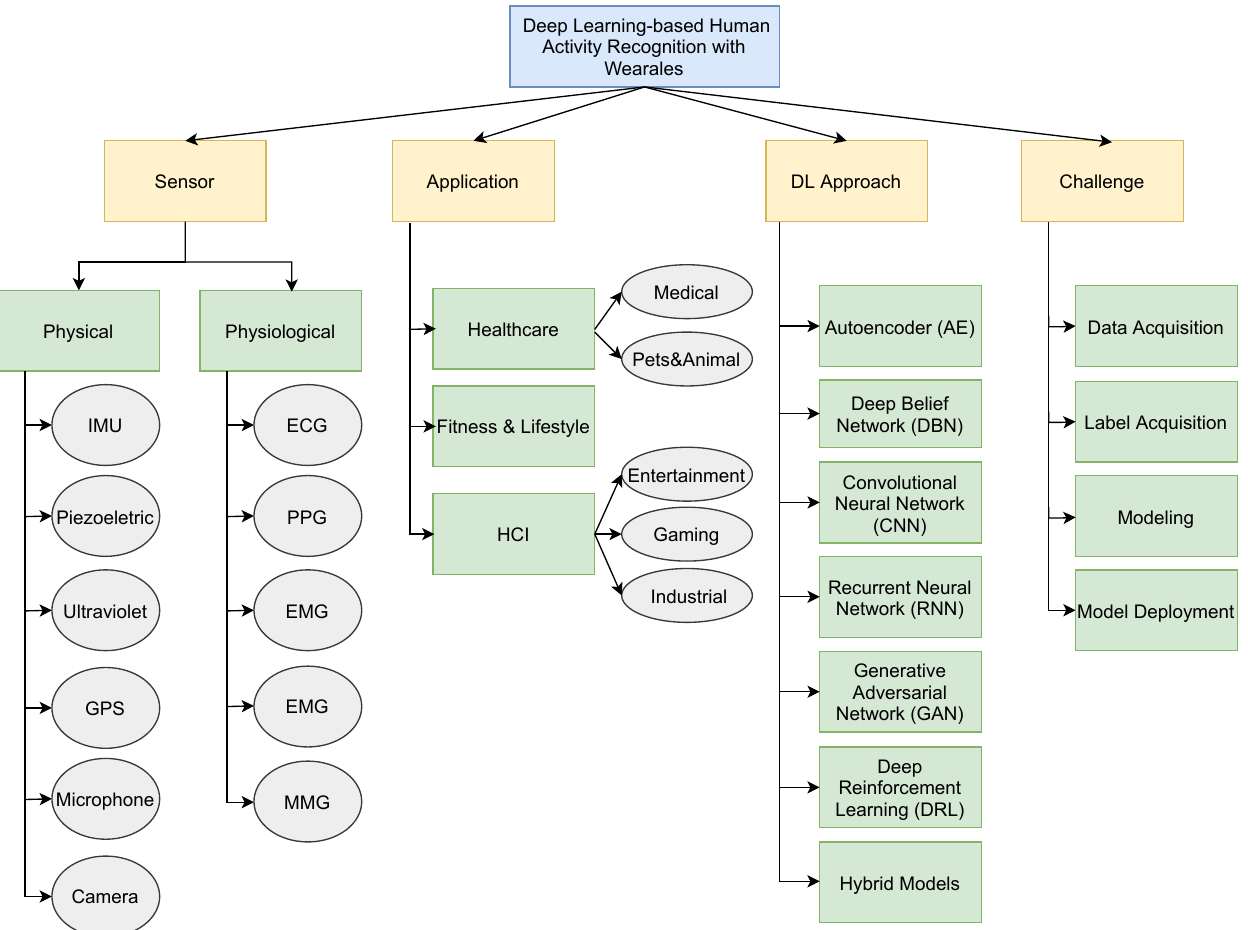
Figure 3. Taxonomy of Deep Learning-based Human Activity Recognition with